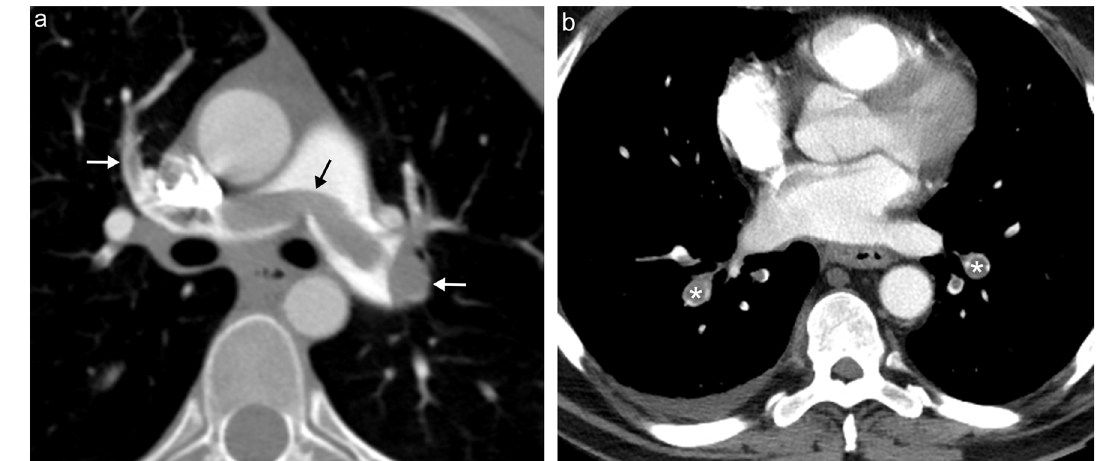
Fig. 9 Two patients with acute pulmonary emboli. a Axial contrast- enhanced CTimage shows a large saddle embolus of the main pulmonary artery ( black arrow ) as well as lobar/segmental involvement of the right and left pulmonary arteries ( white arrows ). b Axial contrast-enhanced CT